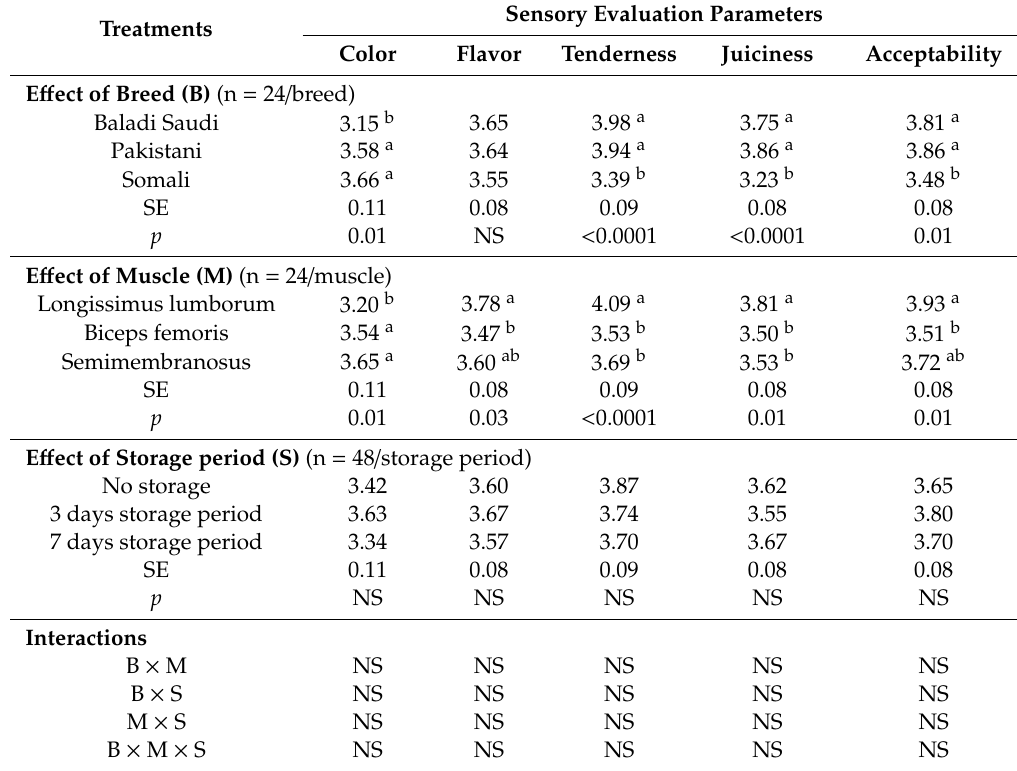
Table 4. E ff ect of breed, muscle type, and storage period on sensory evaluation attributes of camel meat. Sensory Evaluation Parameters Treatments Color Flavor Tenderness Juiciness